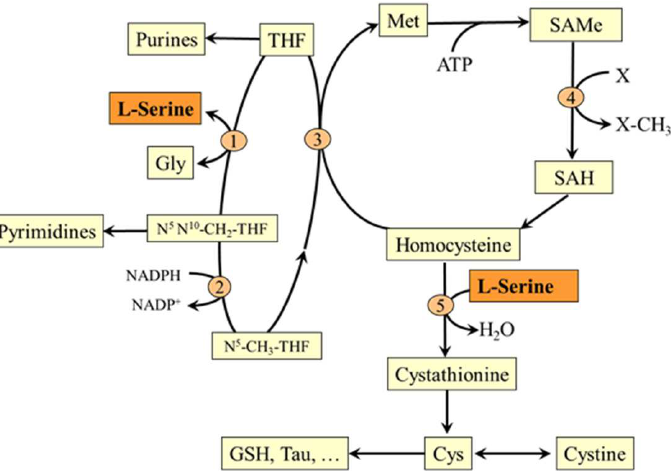
Figure 6. Relationship of L-serine to folate and the methionine cycle and transsulfuration pathway. 1, serine hydroxymethyltransferase; 2, methylene tetrahydrofolate reductase; 3, methionine synthase; 4, methyltransferase; 5, cystathionine β-synthase. SAH, S-adenosylhomocysteine; SAMe, S-adenosylmethionine. GSH, glutathione.